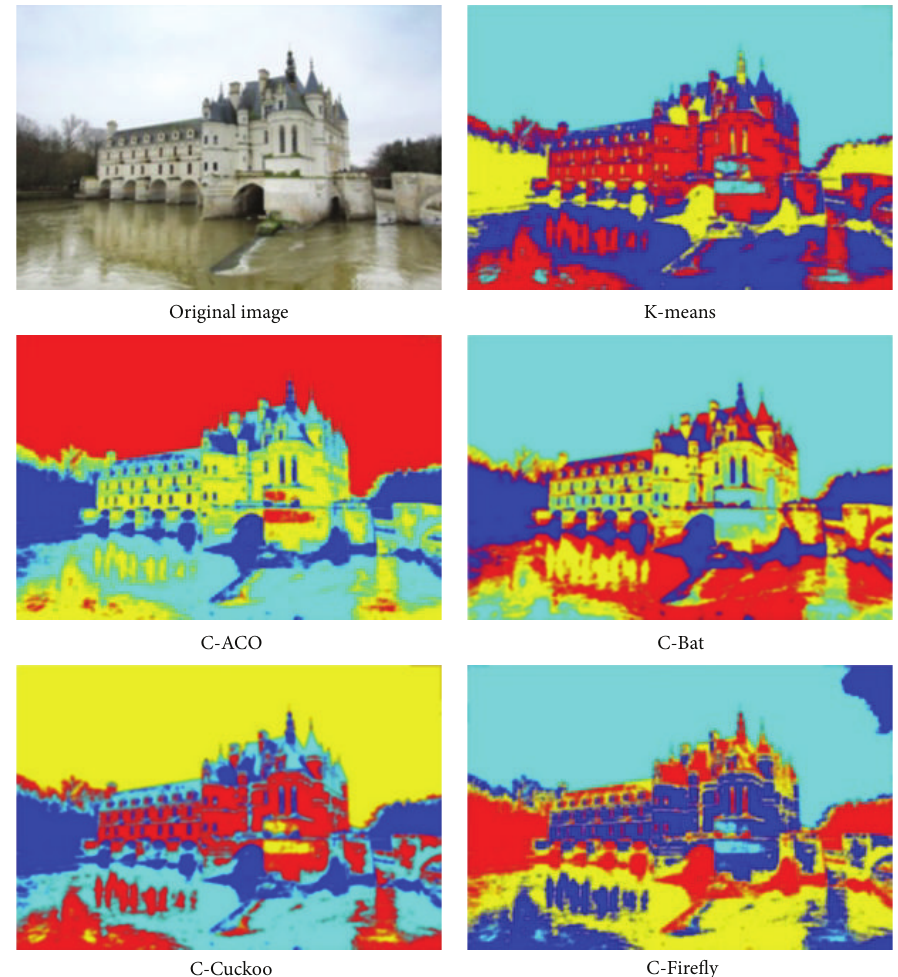
Figure 12: Results of image segmentation by using different nature-inspired clustering algorithms, on a photo called “Chˆateau de